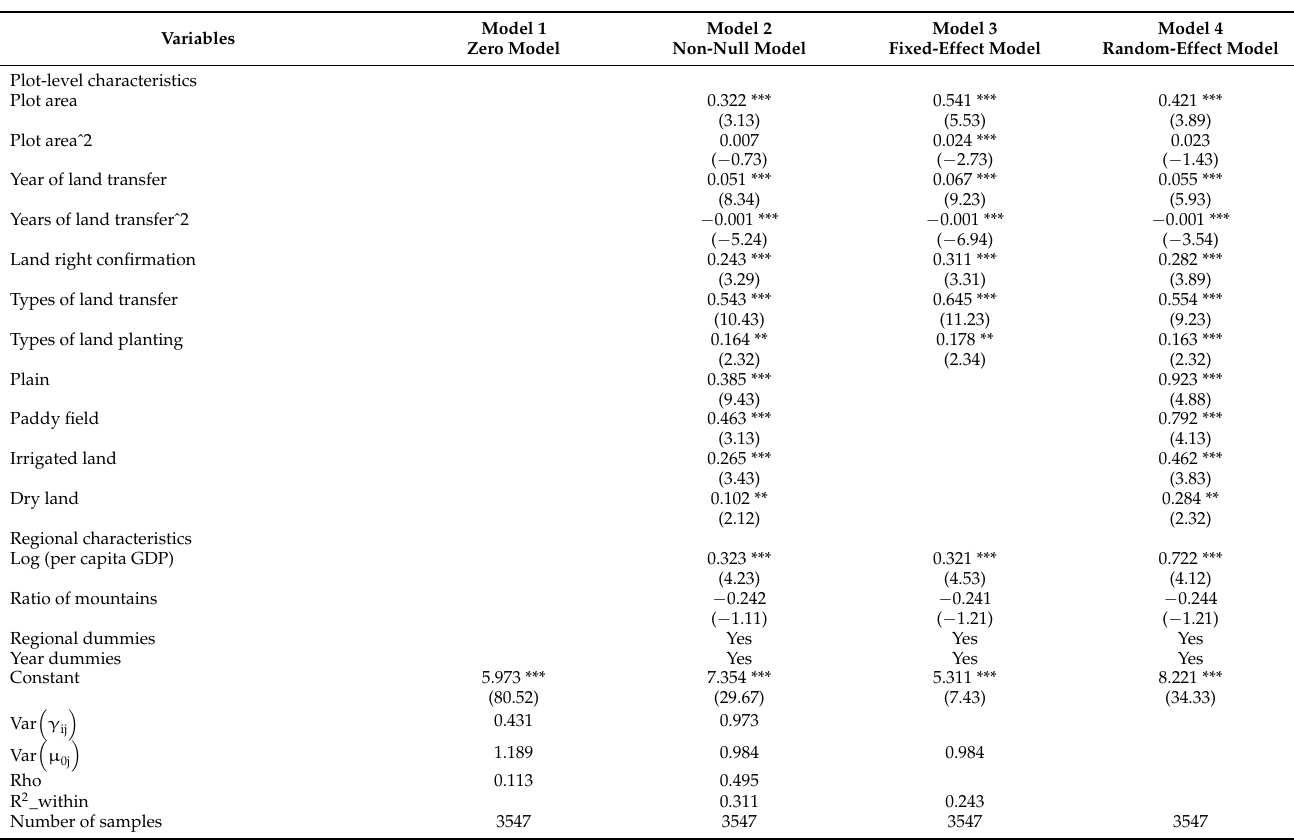
Table 2. Driving factors of rent difference of cultivated land